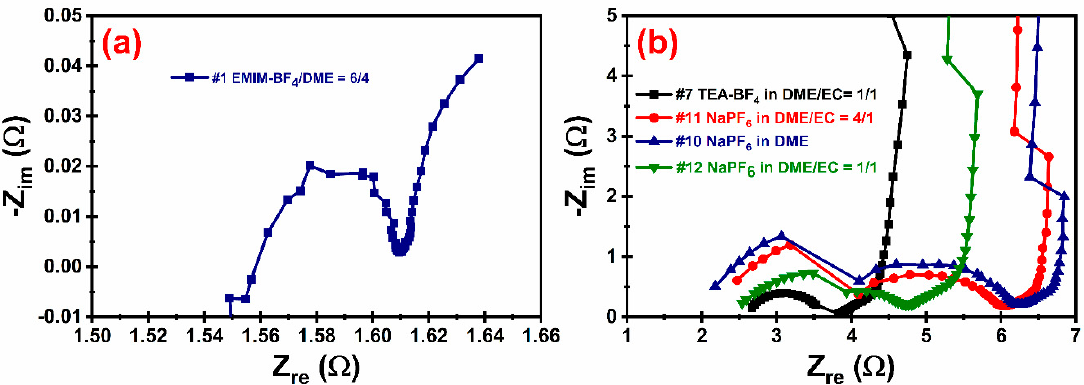
Figure 4. Electrochemical impedance spectroscopy ( EIS) of coin cells with different electrolytes. ( a ) ( a ) EMIM–BF 4 / DME = 6 / 4 and ( b ) 1 M TEA–BF 4 EC / DME = 1 / 1, 1 M NaPF 6 in DME, 1 M NaPF 6 in EMIM–BF 4 /DME = 6/4 and ( b ) 1 M TEA–BF 4 EC/DME = 1/1, 1 M NaPF 6 in DME, 1 M NaPF 6 in DME/EC DME / EC = 4 / 1, and 1 M NaPF 6 in DME / EC = 1 / = 4/1, and 1 M NaPF 6 in DME/EC = 1/1.